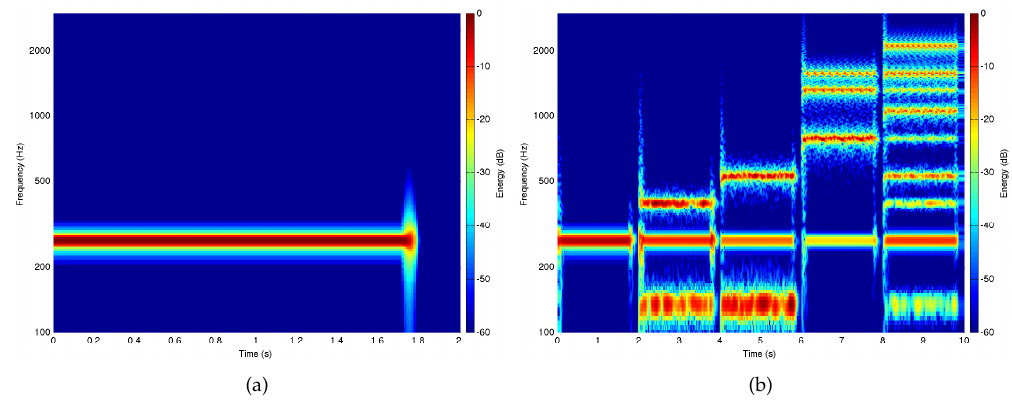
Figure 9. ( a ) C3 sine wave input and ( b ) Hammondized version with five different